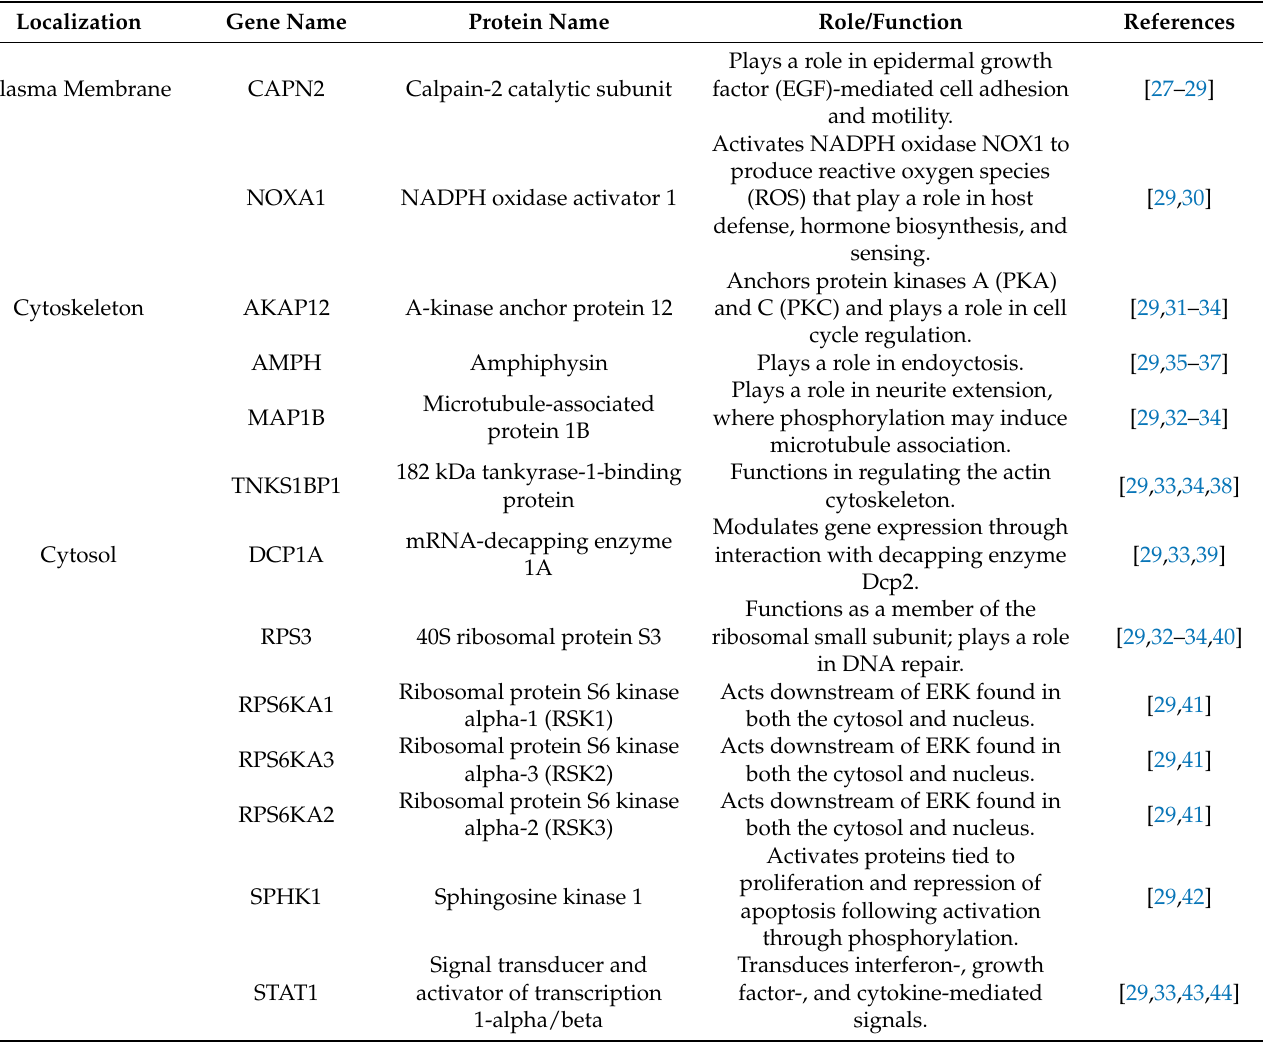
Table 1. Direct ERK interactors identified for both mouse and human. Targets were primarily obtained from a compendium of ERK targets